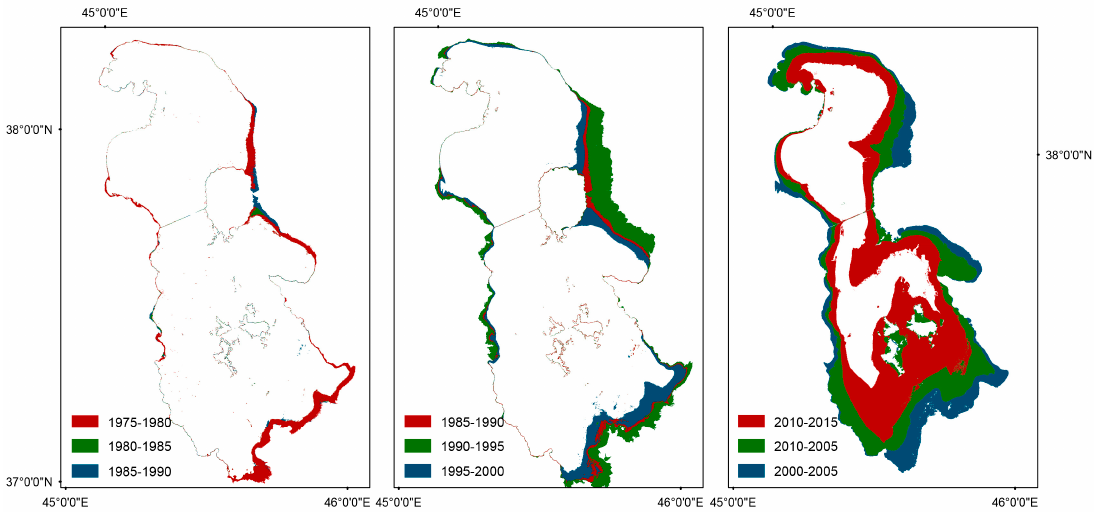
Figure 6. Lake Urmia surface area change maps generated using MLP NNs classifier.